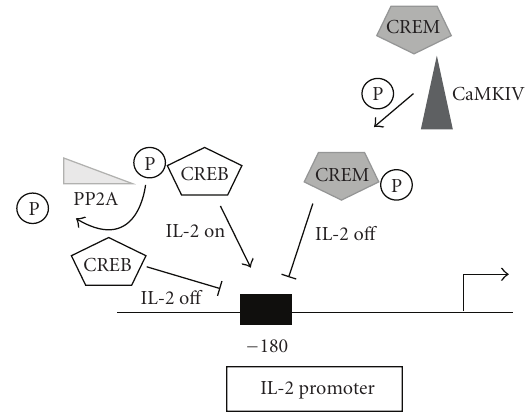
Figure 1: IL-2 transcriptional regulation in T cells. Upon T cell activation, CREB is phosphorylated leading to IL-2 transcription. CREM is also phosphorylated upon T cell activation and it will displace pCREB to shut down IL-2 transcription. CaMKIV is upregulated in SLE and it is responsible for phosphorylation of CREM. PP2A is also upregulated in SLE and this phosphatase dephosporylates